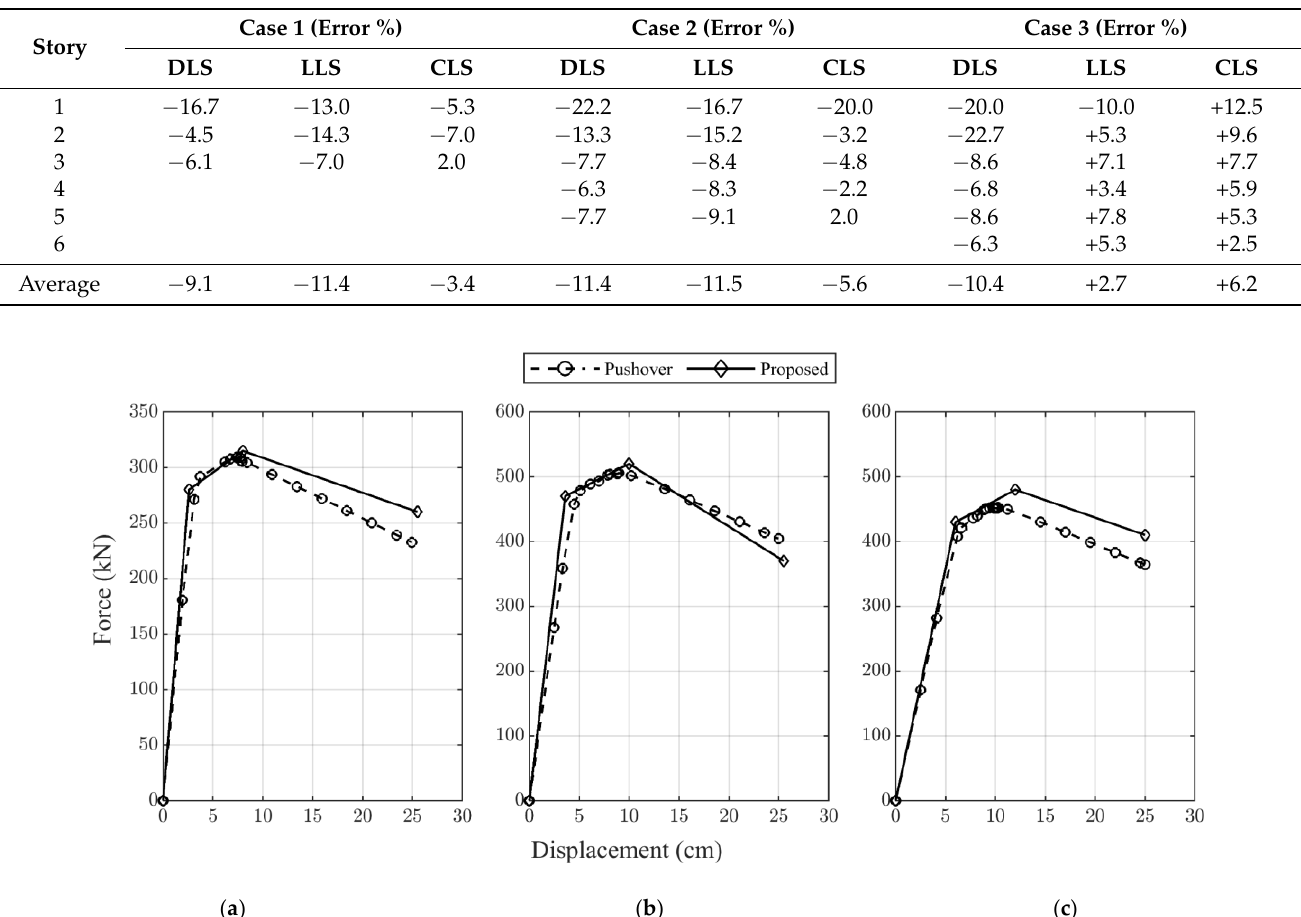
Table 2. Drift error between rigorous pushover and proposed method.